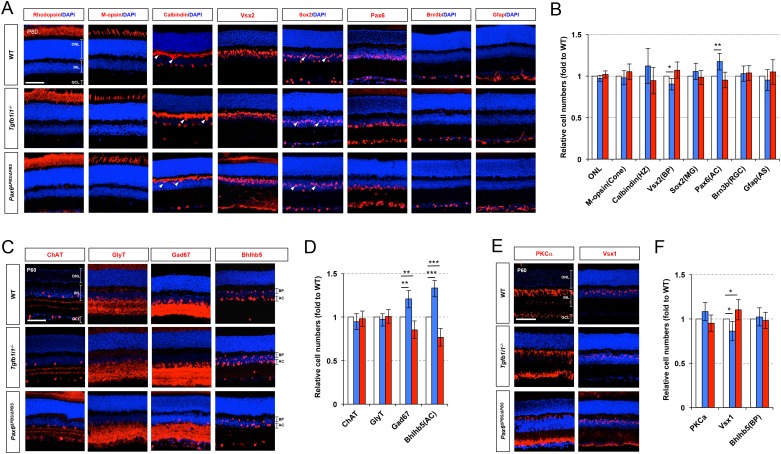
Cell composition of P60 WT, Tgfb1i1−/−, and Pax6ΔPBS/ΔPBS mouse retinas.(A) Composition of P60 WT, Tgfb1i1−/−, and Pax6ΔPBS/ΔPBS mouse retinas were determined by examining cell type-specific markers. Rhodopsin, rod photoreceptors; M-opsin, M-cone photoreceptors; Calbindin, horizontal cells (HZ; arrowheads); Vsx2, bipolar cells (BP); Sox2, Müller glia (MG; arrowheads); Pax6, amacrine cells (AC); Brn3b, retinal ganglion cells (RGCs); glial fibrillary acidic protein (Gfap), astrocytes (AS). Scale bar, 100 μm. (B) Relative numbers of marker-positive cells in P60 Tgfb1i1−/−and Pax6ΔPBS/ΔPBS mouse retinas were determined by comparing with those in their WT littermate mice. Error bars denote STD (n = 4, two independent litters). *p<0.05; **p<0.01. (C) Distribution of amacrine cell subtypes in P60 WT, Tgfb1i1−/−, and Pax6ΔPBS/ΔPBS mice were determined by examining cell type-specific markers. ChAT, cholinergic; GlyT1, glycinergic; Gad67 and Bhlhb5 (AC in the bottom half of INL), GABAergic. Scale bar, 100 μm. (D) Relative numbers of marker-positive cells in P60 Tgfb1i1−/−and Pax6ΔPBS/ΔPBS mouse retinas were determined by comparing with those in their WT littermate mice. Error bars denote STD (n = 4, two independent litters). **p<0.01; ***p<0.001. (E) Distribution of bipolar cell subtypes in P60 WT, Tgfb1i1−/−, and Pax6ΔPBS/ΔPBS mice were determined by examining cell type-specific markers. PKCα, rod bipolar cell; Vsx1 and Bhlhb5 (BP in the top of INL in (C)), OFF bipolar cells. Scale bar, 100 μm. (F) Relative numbers of marker-positive cells in P60 Tgfb1i1−/−and Pax6ΔPBS/ΔPBS mouse retinas were determined by comparing with those in their WT littermate mice. Error bars denote STD (n = 4, two independent litters). *p<0.05; **p<0.01; ***p<0.001.